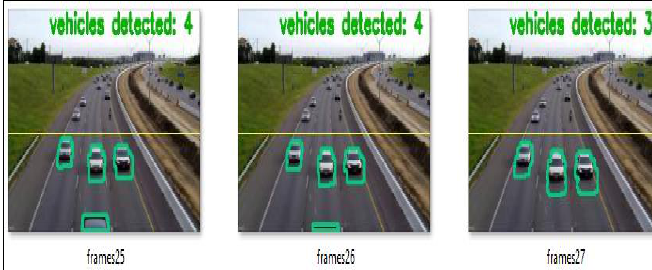
Figure 7: Counting the vehicle number.